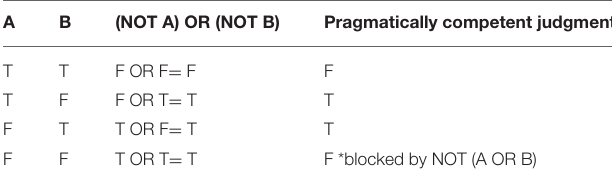
TABLE 2 | Logical truth table and expected judgments of disjunction wide